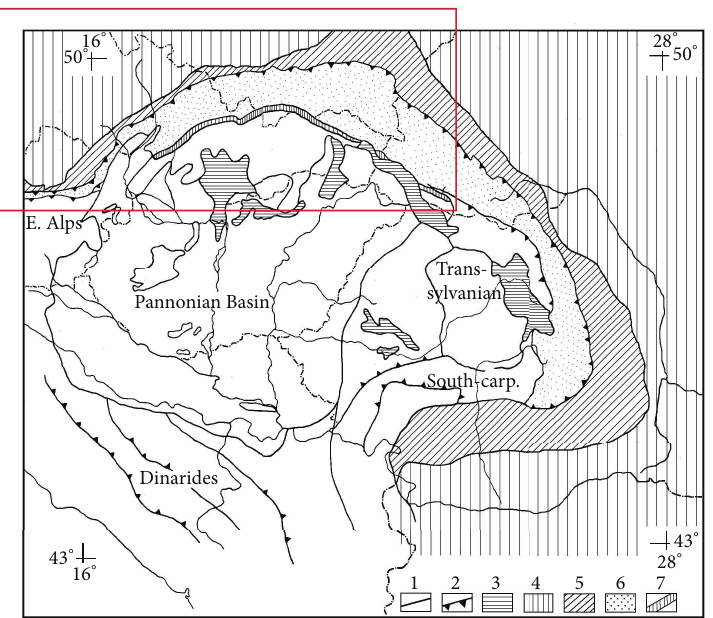
Figure 2: Simplified tectonic map of Carpathians and Pannonian Basin (adapted from [14]) in WGS84 geographical coordinates system as reference: (1) limit of structural units, (2) thrusting fronts, (3) neovolcanic rocks, (4) European plate, (5) mollasic foredeep, (6) outer Carpath (Flysch), and (7) Pieniny Klippen belt. Approximate position of the area of this study is outlined by the red box located at the north-west part of the map.